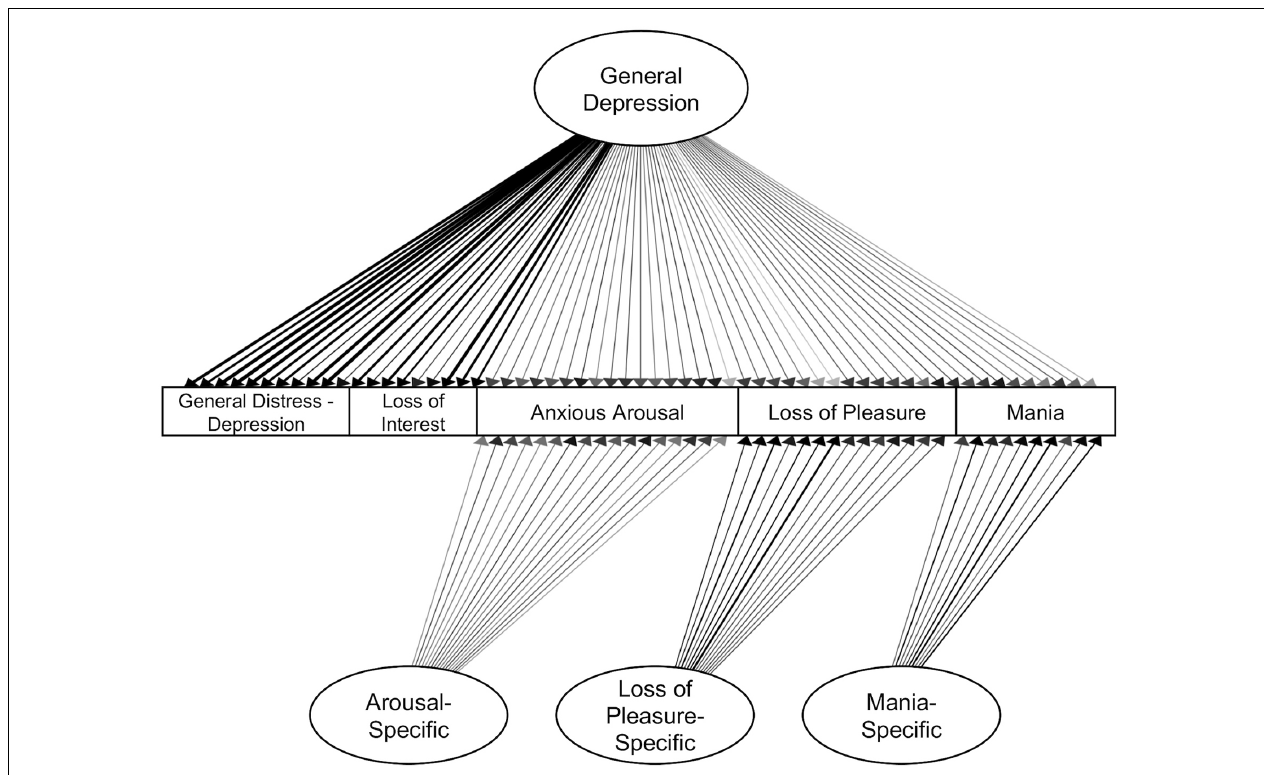
FIGURE 3 | Confirmatory bifactor model of symptoms. Standardized estimates shown. All factor loadings were significant ( p s < 0.05). Darker lines indicate larger